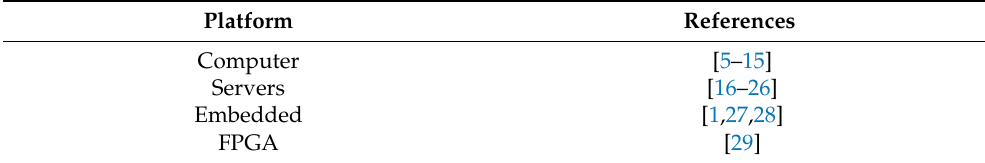
Table 1. Other research works on measuring the performance of hypervisors in electronic